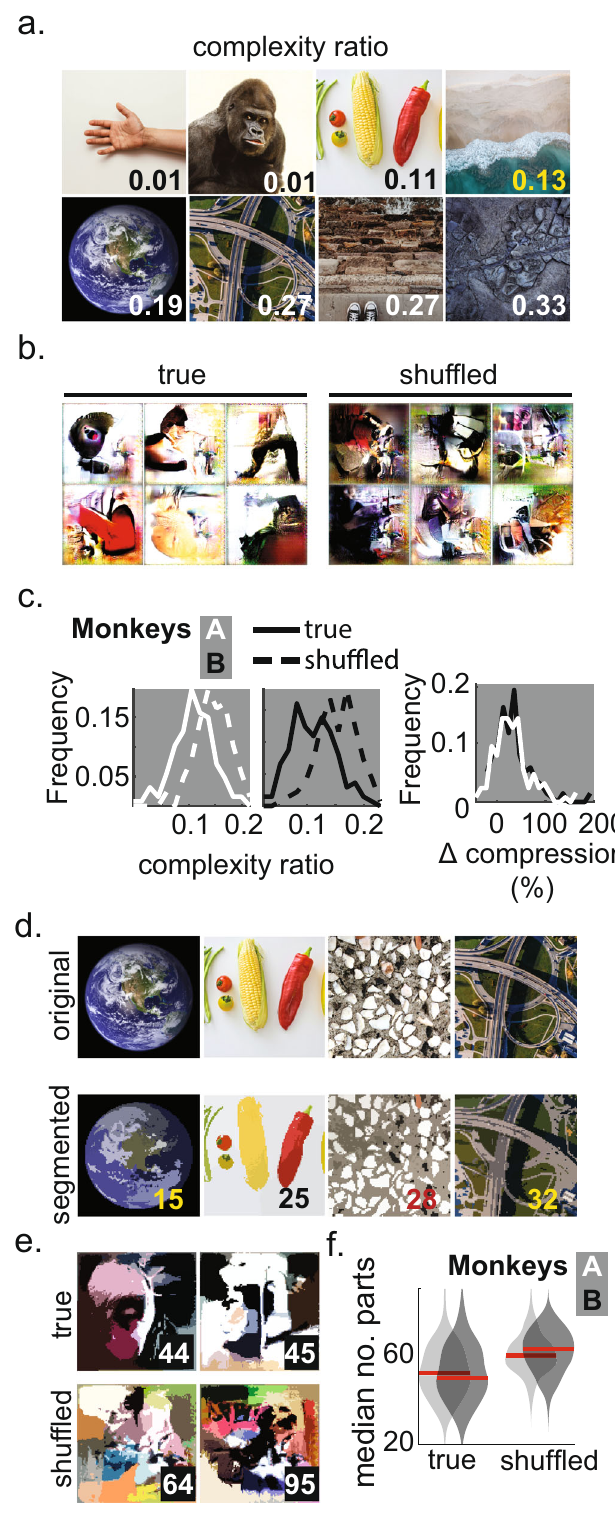
information than typical photographs (consistent with views of ef fi cient coding) but prefer more information than typically present in classic stimulus sets. Lastly, we measured the complexity ratio of prototypes evolved from AlexNet units and found they were higher than those of the biological prototypes (Supplementary Fig. 2; AlexNet prototype median complexity ratio of 0.209 ± 0.003 per 218 units sampled